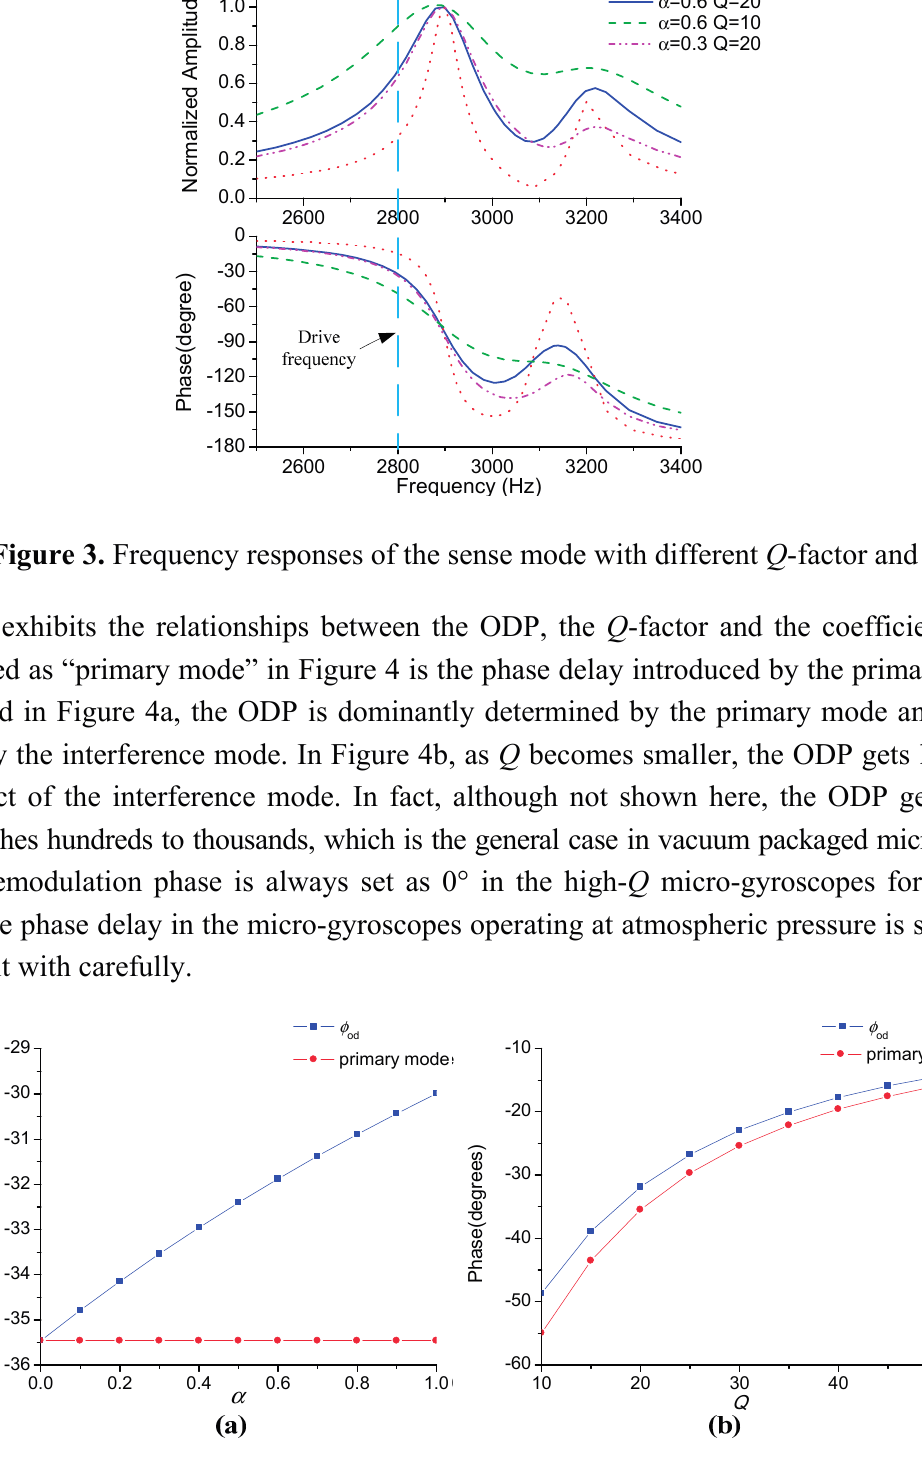
= 3200 Hz , (cid:1858) = 2800 Hz and (cid:1843) (cid:3041)(cid:3052)(cid:2870) (cid:3031) = (cid:1843) = (cid:1843) (cid:2869) (cid:2870)